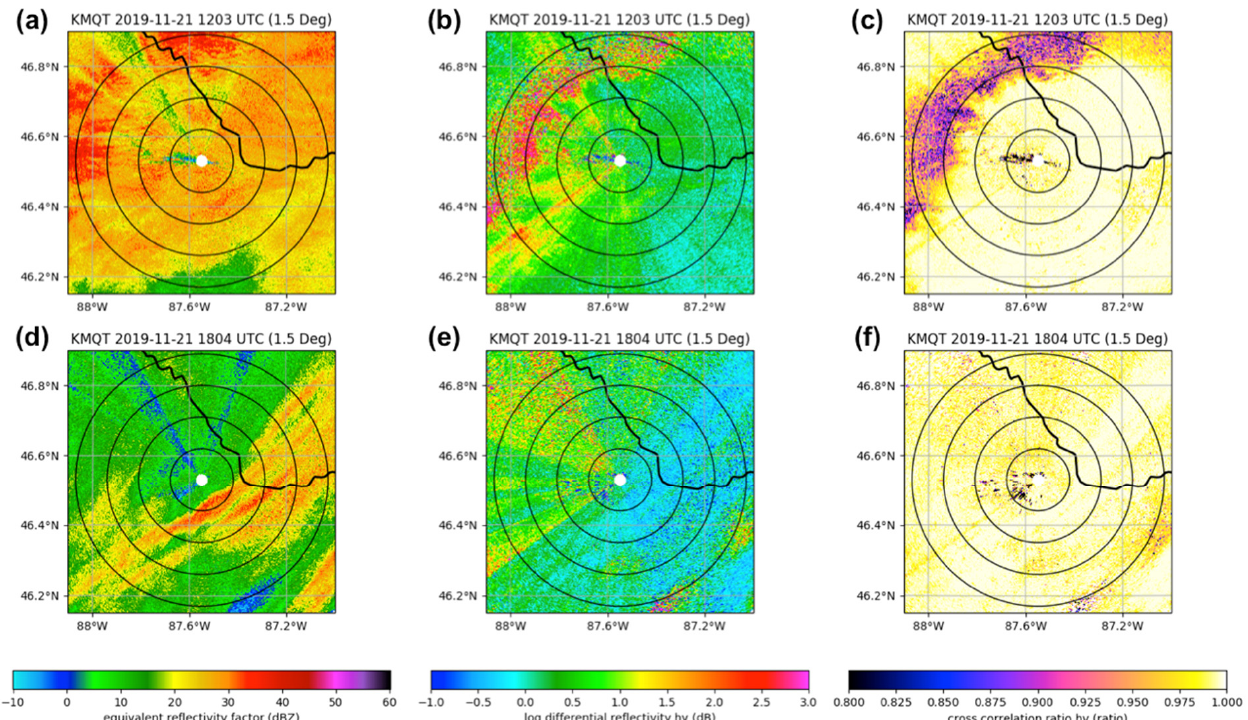
Figure 6. WSR-88D values of reflectivity, differential reflectivity (Z DR ), and cross correlation ratio ( ρ HV ) during the rain period (1203 UTC, panels ( a – c ) and the snow period (1804 UTC, panels ( d – f )) for the event on 21 November 2019. The rings denote 10 km radial distance from the radar.